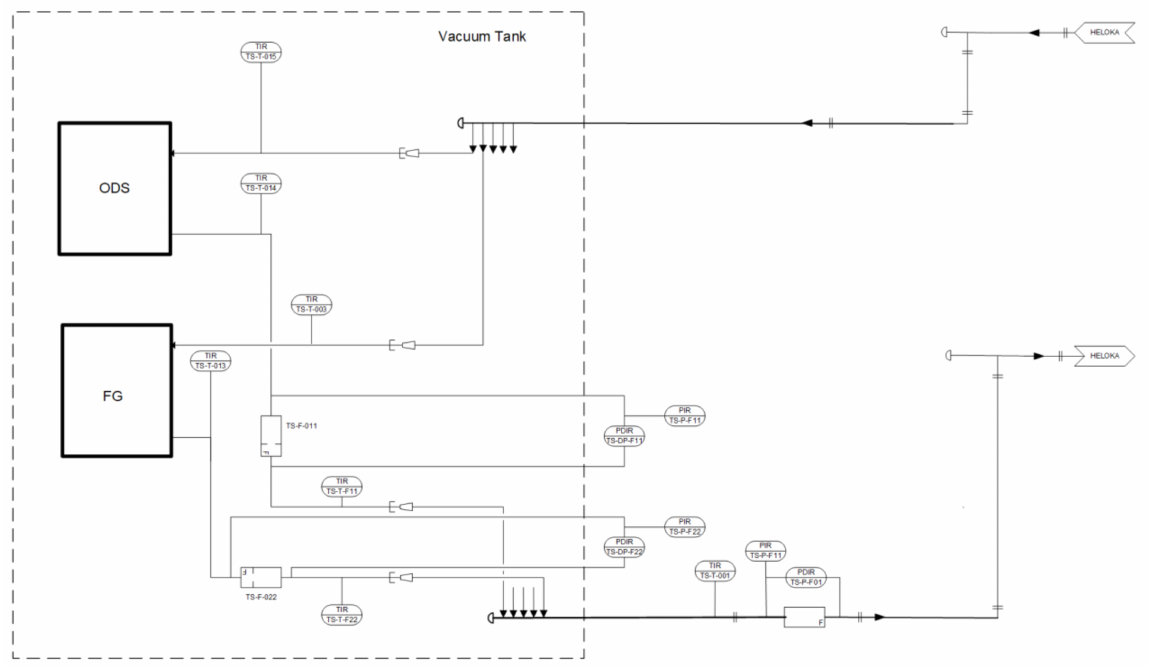
Figure 5. Piping and Instrumentation Diagram for the experimental set-up. Table 2. List of helium parameters monitored for the ODS